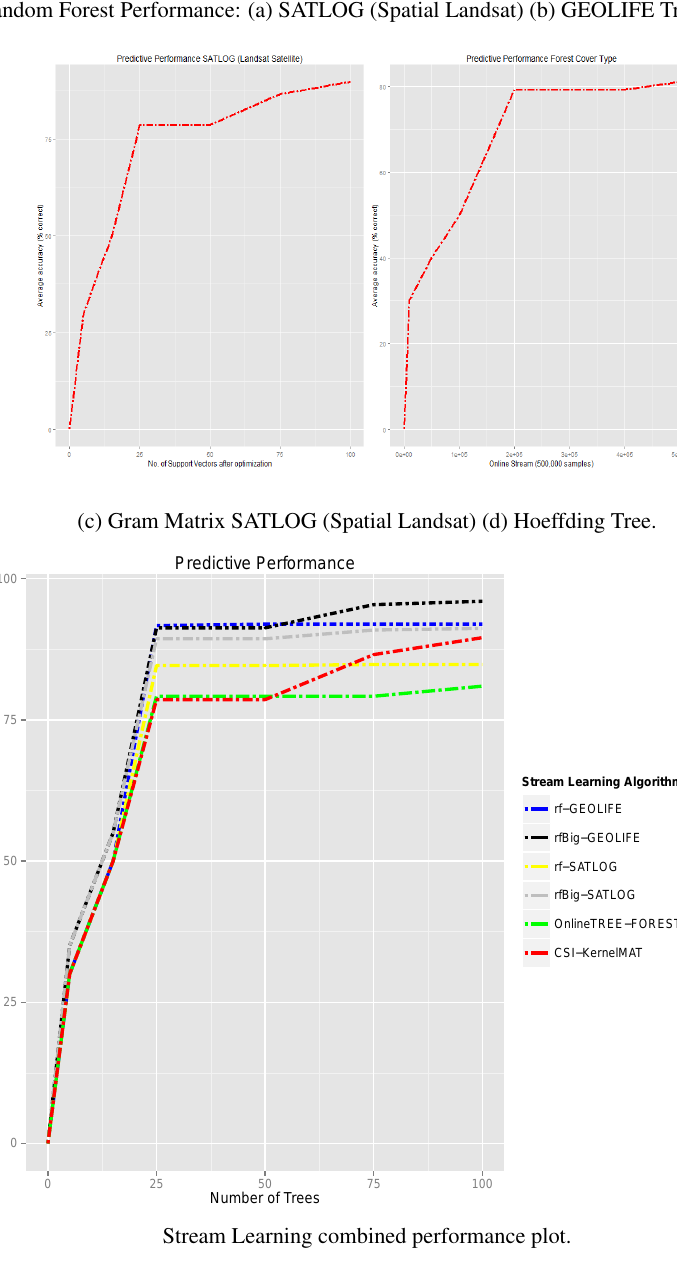
Fig. 5 Average accuracy of randomForest, randomForest-Big, CSI-Kernel matrix and Hoeffding tree and over many datasets versus the maximum number of options per example. Accuracies were estimated to perform memory optimizations for the final model. The real-time streaming is show in green which performs close to the best known batch tree